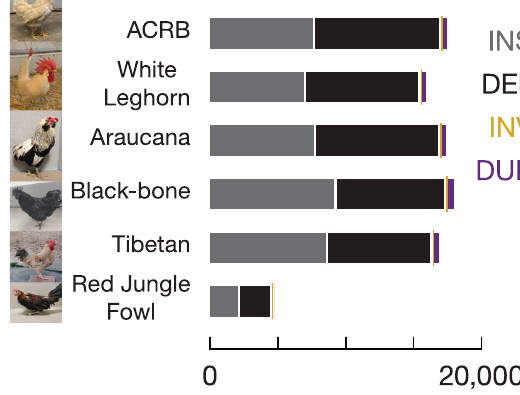
Fig.2|ChickenpiRNAlociareSVhotspots.a ThelandscapeofSVsinchickens.(i) QuantityofeachtypeofSV,(ii)densityplotsshowingtheirlengthdistributions,and (iii) pie chart showing their overlapping genomic regions. b Bar plots of the quantity of SVs in each chicken. INS, insertion; DEL, deletion; INV, inversion; DUP, tandem duplication. The Red Jungle Fowl had a signi fi cantly lower number of SVs compared tothatof domesticated chickens(Zscore= − 15.9).GivenourRedJungle